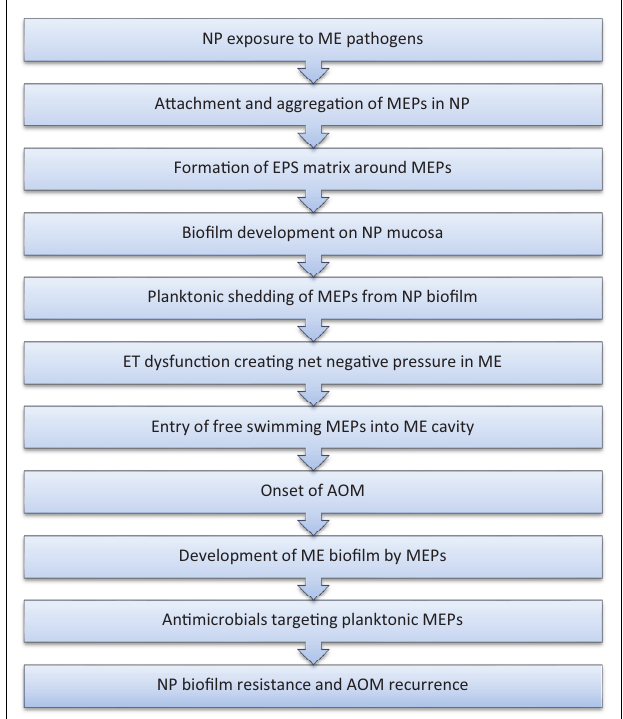
FIGURE 1 | Proposed algorithm for RAOM pathogenesis